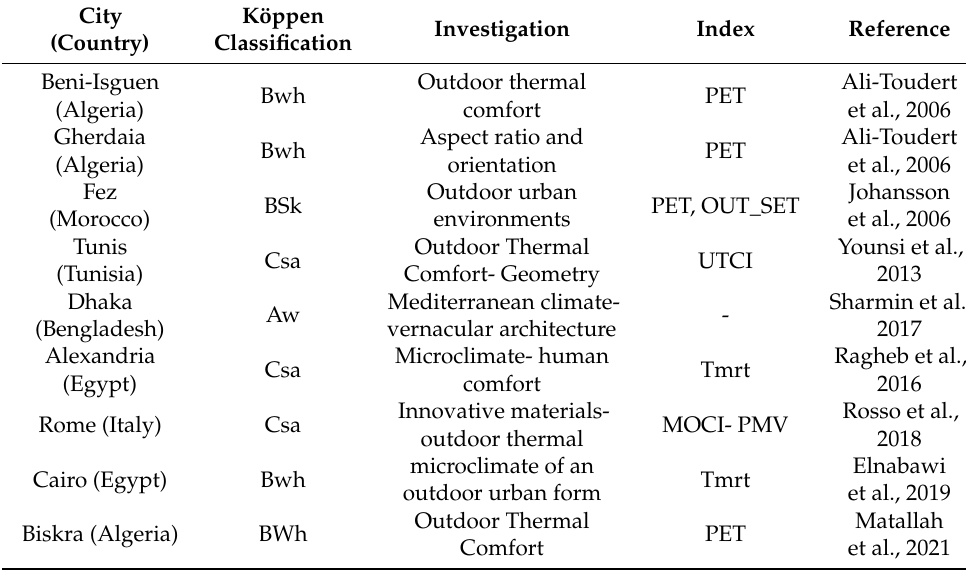
Table A2. Studies on outdoor thermal comfort in traditional